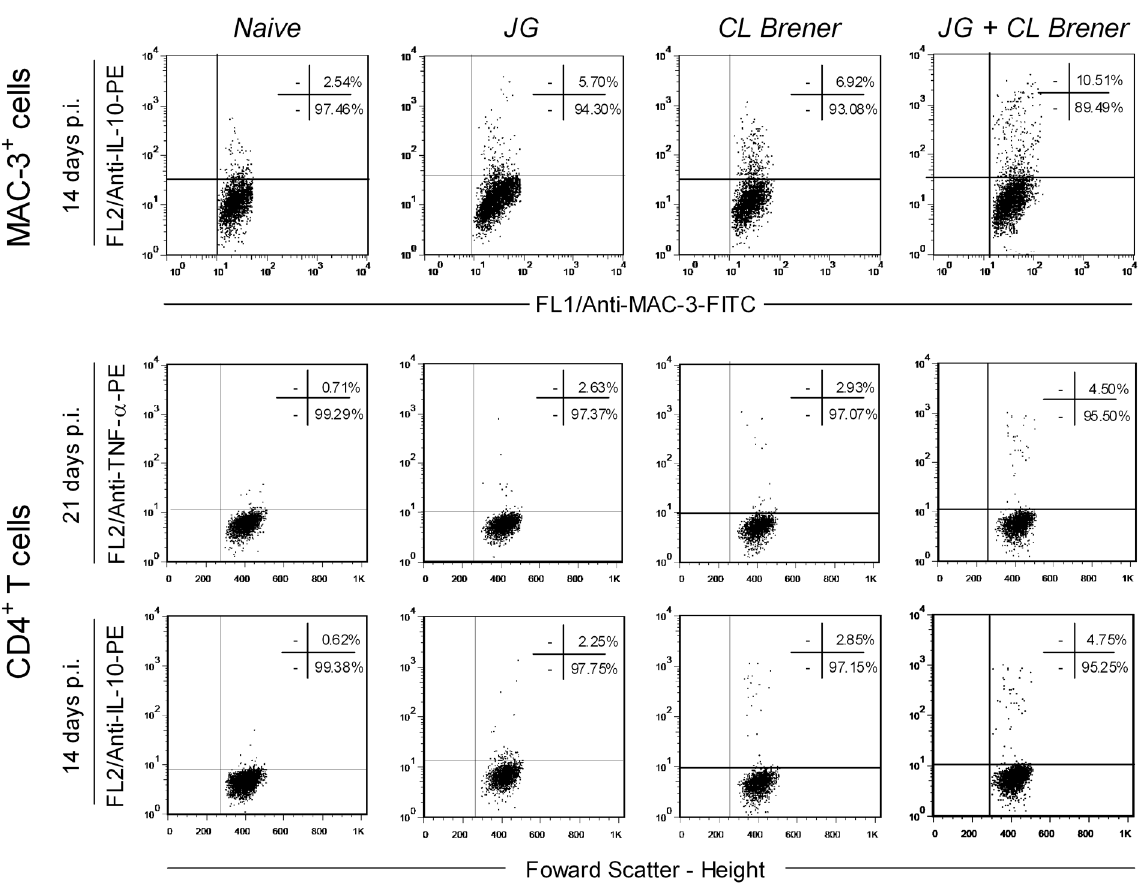
Figure 9. Representative flow cytometry charts illustrating the cytokine synthesis by spleen MAC-3 + and CD4 + T cells from BALB/c mice infected with JG and/or CL Brener. Results are presented in density plot format. The analyses were performed by quadrant statistics expressed as the percentage of cytokine + cells within gated MAC-3 + at 14 days p.i., and CD4 + cells at 14 and 21 days p.i. in splenocytes cultures from naı¨ve, JG single infected, CL Brener single infected and JG and CL Brener coinfected mice. Cytokine flow cytometry charts demonstrate the enhanced percentage of cytokine + cells in all infected mice. Outstanding levels of TNF- a -producing CD4 + T cells were contra balanced by high frequency of IL- 10-producing MAC-3 + and CD4 + T cells in coinfected